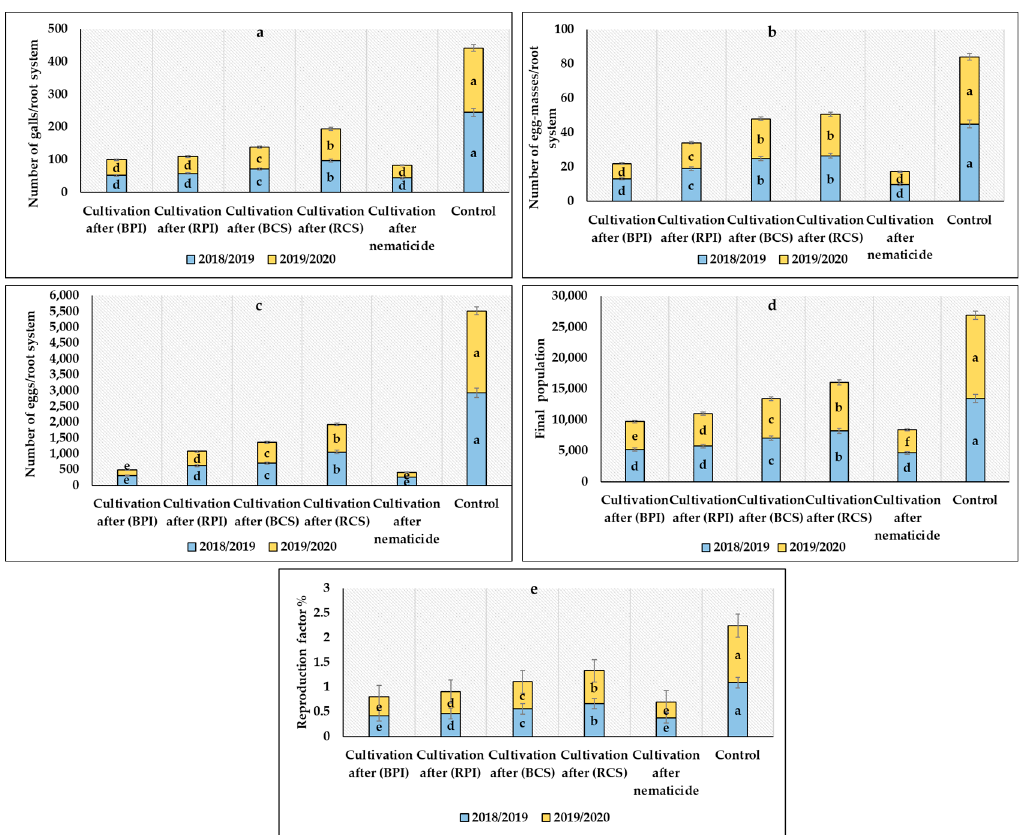
Figure 5. The effects of biofumigation, crop sequence, nematicide treatments compared with control on cucumber root systems in two seasons 2018/2019 and 2019/2020. (( a ) the number of nematode galls, ( b ) egg masses, ( c ) eggs, ( d ) final population, ( e ) reproduction factor). Means (± SE) followed by the same letter are not significantly different at p ≤ 0.05 (LSD test).